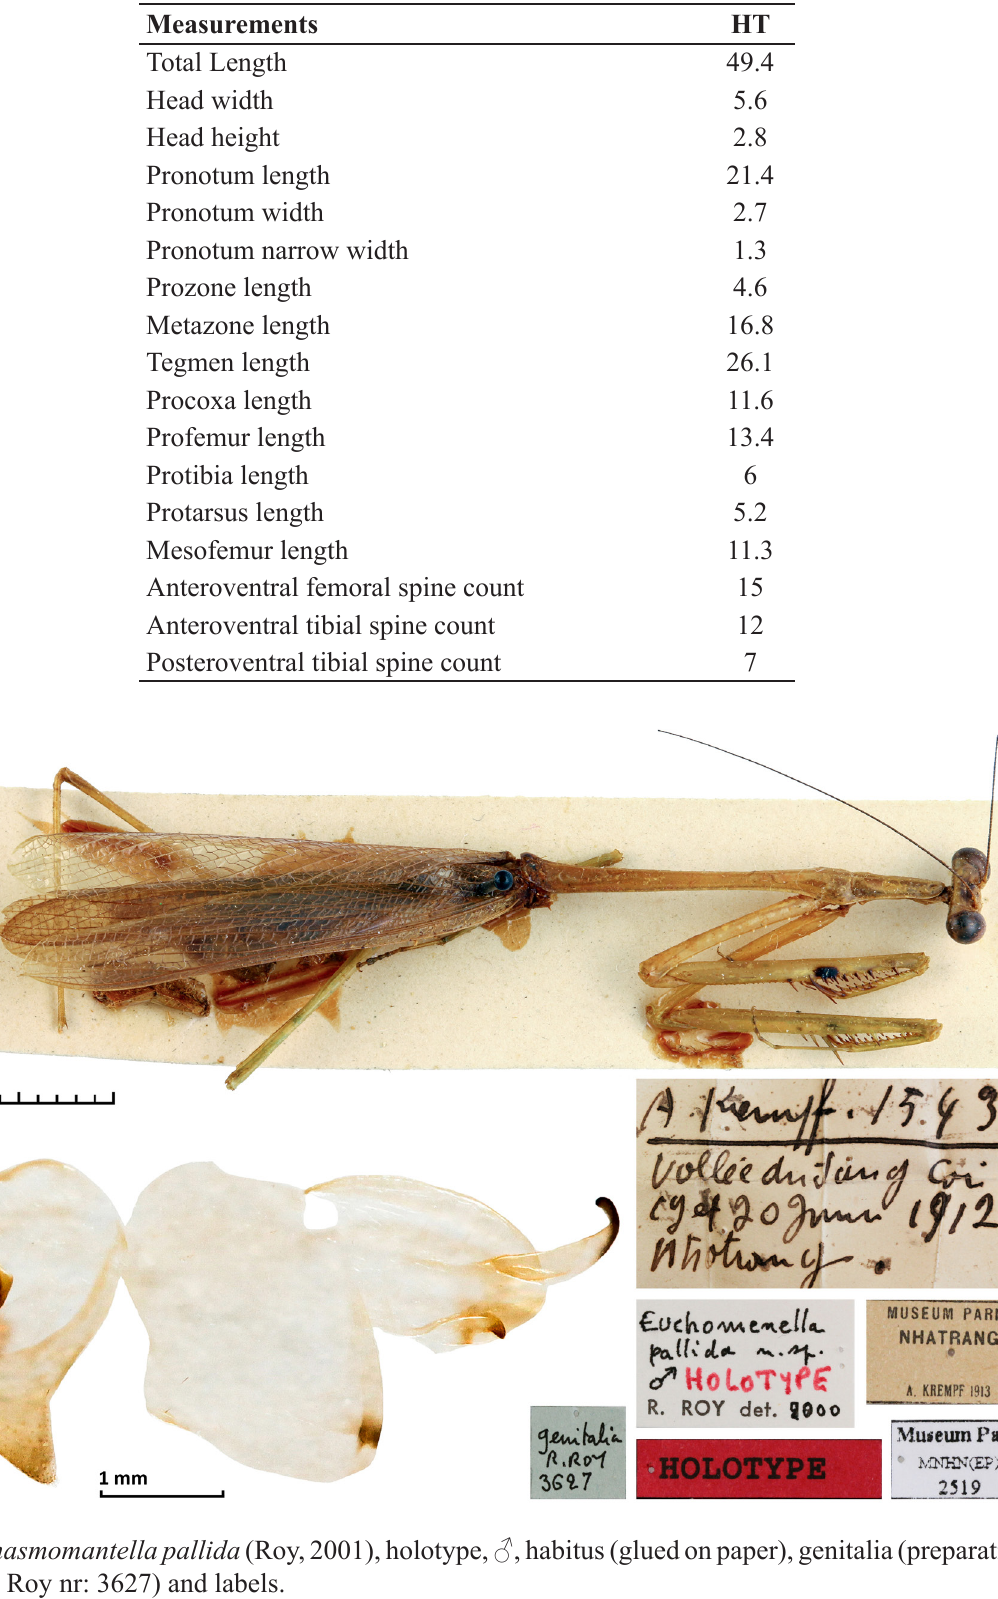
Table 2. Measurements and spine counts for the holotype (HT) of Phasmomantella pallida (Roy,